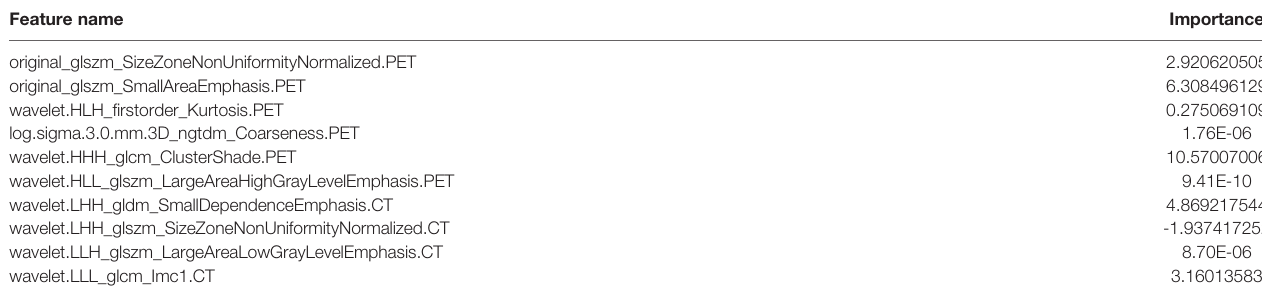
TABLE 3 | Radiomics features for calculating PET/CT radiomics scores (Rad-scores) of OS and their importance.